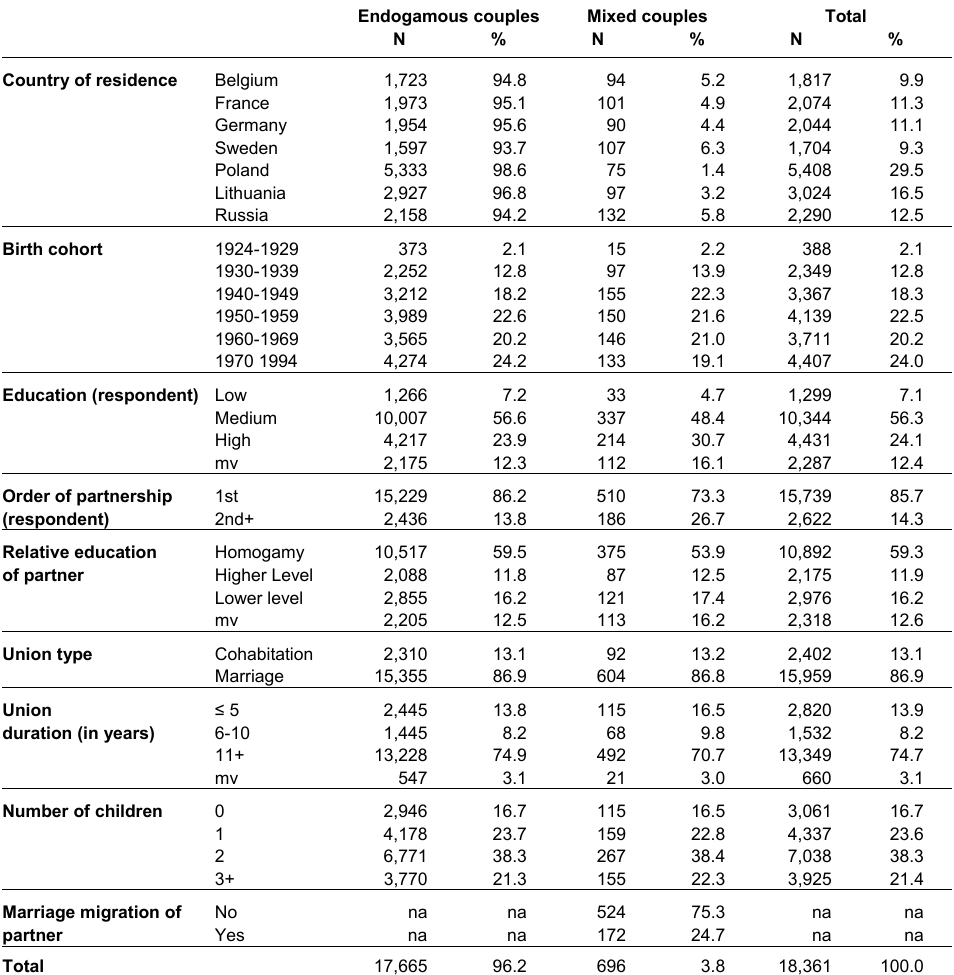
Table 1.2 : Descriptive overview of the sample for native men, by couple type Endogamous couples Mixed couples Total N % N % N